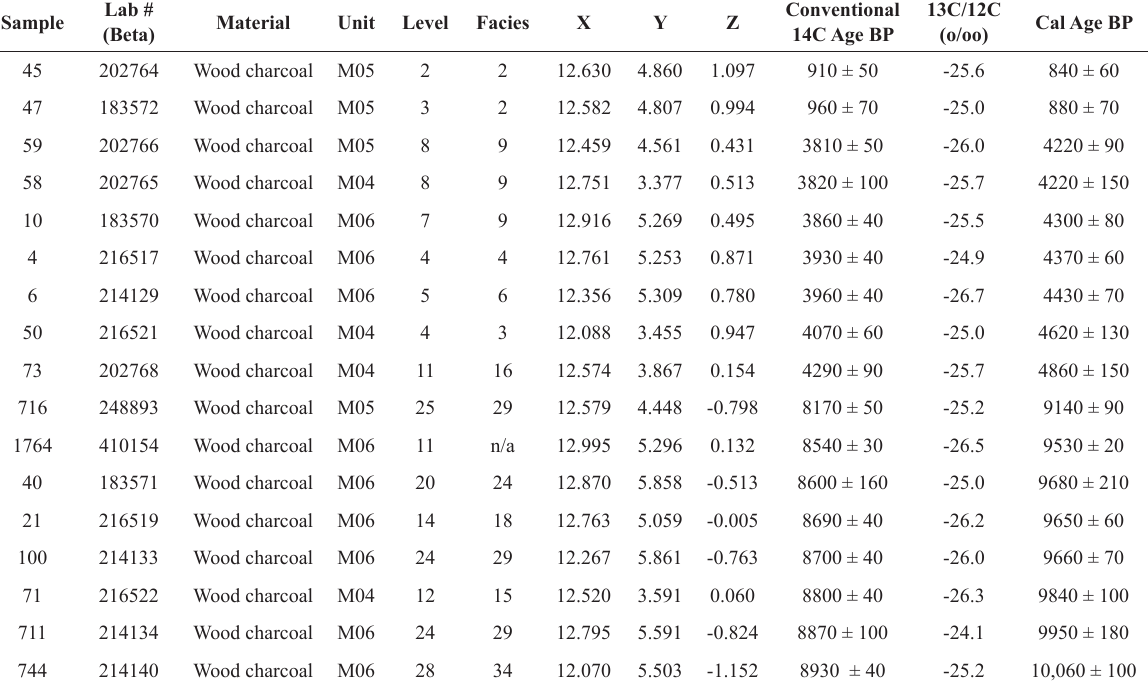
Radiocarbon ages for the M Units, Lapa do Santo. Calibrated ages obtained using CalPal 2007 (Weninger et al.